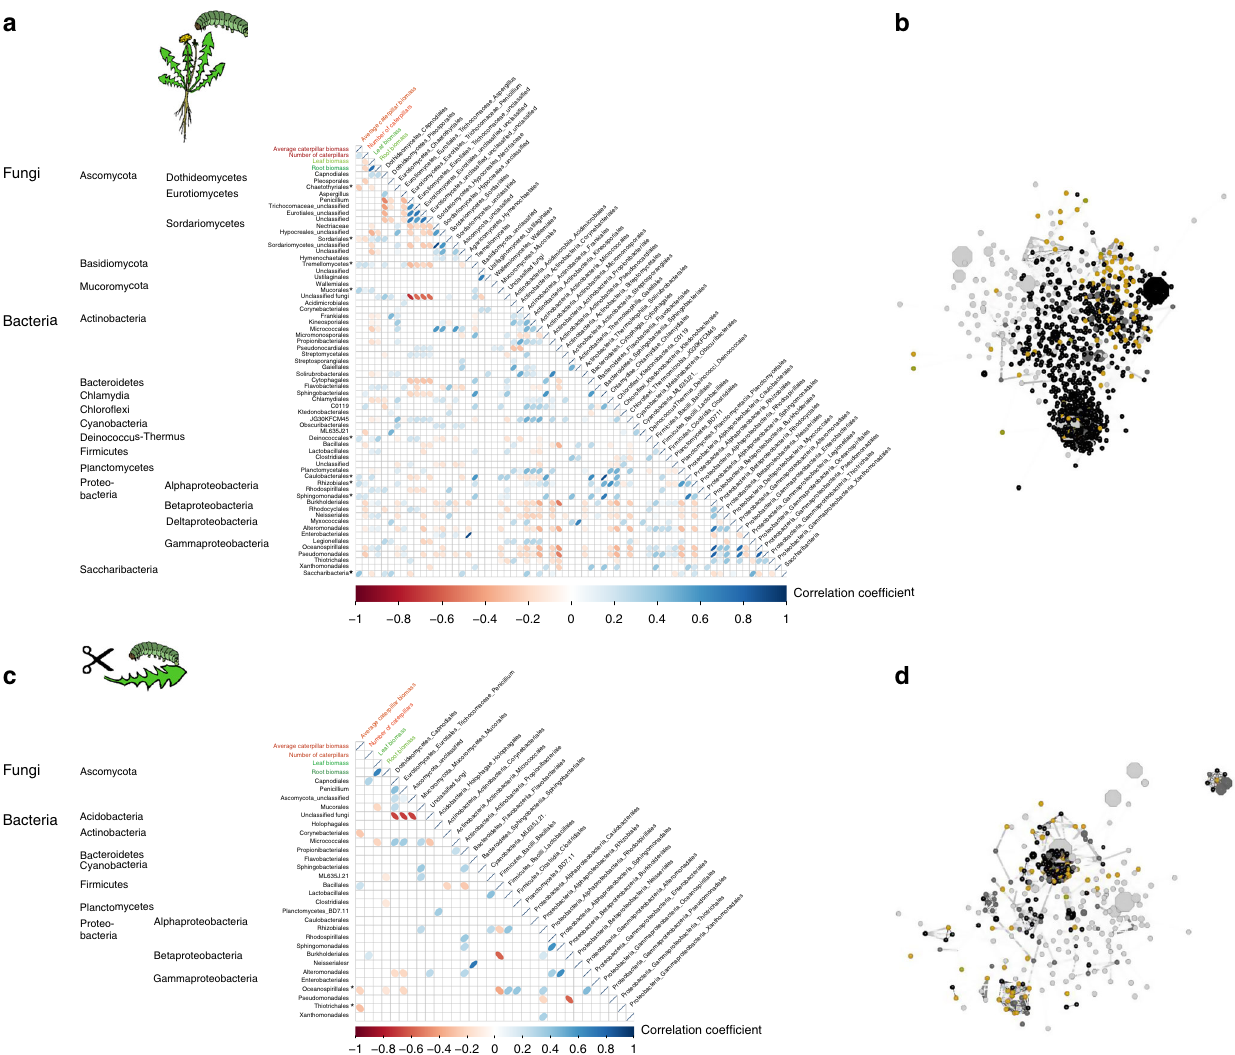
Fig. 4 Correlations between caterpillar parameters, plant parameters, and relative abundance of fungal and bacterial taxa in the caterpillars. a fungal orders and bacterial classes detected in caterpillars fed on intact plants, and c on detached leaves. Correlations are based on linear Pearson correlation coef fi cients against each other and average caterpillar biomass (red), caterpillar survival (red), and leaf- and root biomass (green). The scale color of the fi lled squares indicates the strength of the correlation ( r ) and whether it is negative (red) or positive (blue). All correlations are corrected with FDR and only signi fi cant correlations with p < 0.05 are shown. If the correlation is not signi fi cant, the box is left white. Asterisks next to names of taxa mark signi fi cant correlation between this taxon and caterpillar performance. b and d represent a network of all signi fi cant co-occurrences (Spearman rank correlation coef fi cient with Bonferroni correction, p < 0.01) of OTUs in caterpillars on intact plants ( b ) or on detached leaves ( d ). The size of the nodes represents the relative abundance of the OTUs (weighted average) and the color represents the compartment where it is primary found. Green depicts OTUs found mostly in leaves, brown OTUs in caterpillars (dark brown OTUs of caterpillars on intact plants and light brown OTUs of caterpillars on detached leaves), black depicts OTUs found primarily in the soil and grey OTUs that are general in all compartments